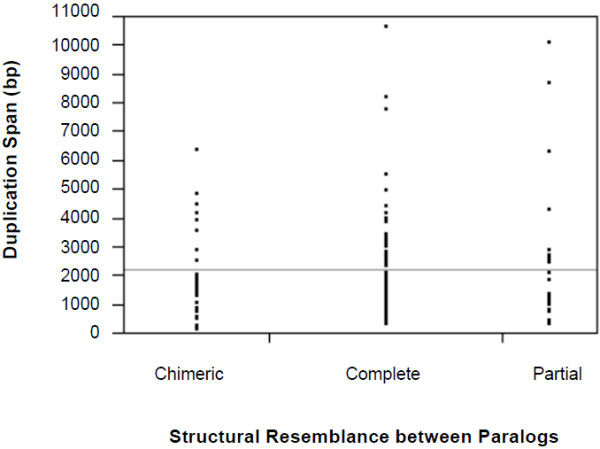
Side-by-side vertical dot plots displaying the distribution of duplication spans for three structural categories of gene duplicates, namely complete, partial and chimeric duplicates (n = 64, 26, and 40 duplicate pairs, respectively). The horizontal line across the graph shows the overall mean of all the observations.